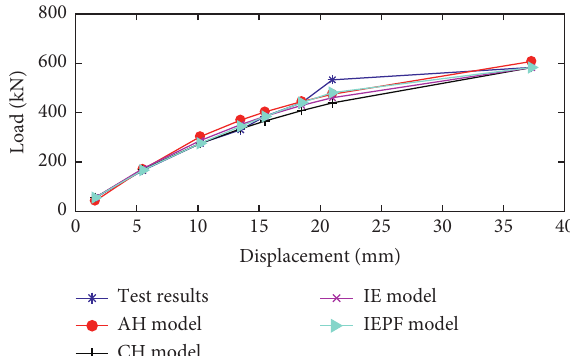
Figure 10: Comparison of each model with the test data from D